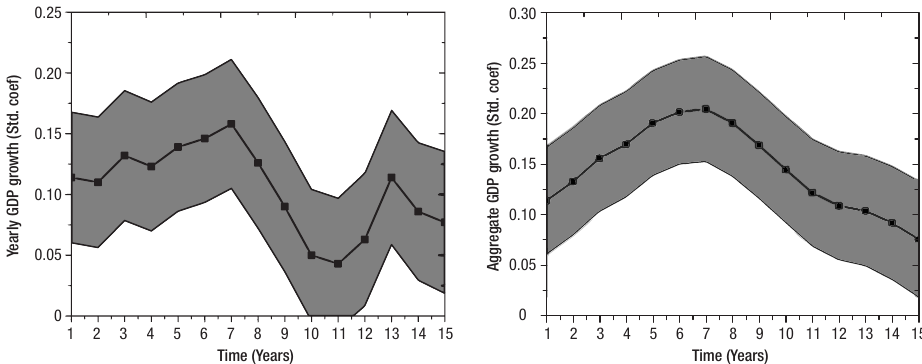
Fig. 4. Relation between the time scale and the standardized coefficients for the composite variables Notes: composite variables represent the trade cycles for category SIC 9. Shaded areas depict a 95% confidence